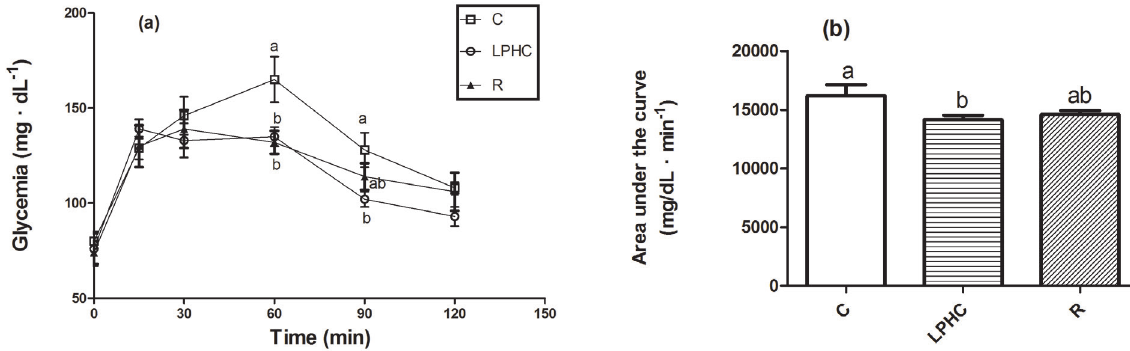
Figure 4 - Serum glucose (mg/dl) ( a ) and area under the curve ( b ) of the oral glucose-tolerance test (OGTT) of rats treated with the control diet (C group) or low-protein, high-carbohydrate diet (LPHC group) for 45 days and rats treated with the LPHC diet for 15 days followed by the control diet until the 45th day (R group). The results are expressed as the means ± standard error of the mean of seven animals per group. Different letters represent significant differences among groups. One-way ANOVA (p<0.05).